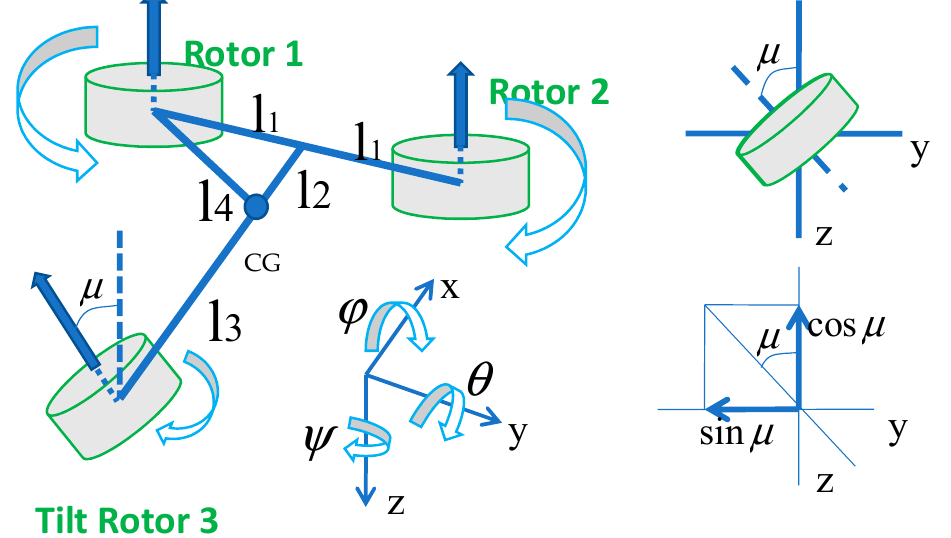
Figure 3. An agricultural tricopter model.